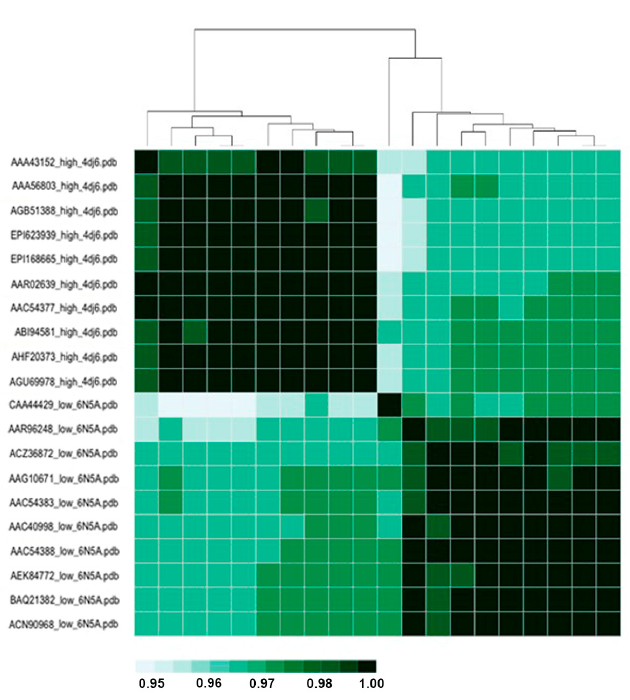
Figure 5. RMSIP heatmap for HPAI and LPAI RBDs. Uniprot AC for each sequence, followed by pathogenicity and PDB of the template are reported on the Y axis, while a distance tree is reported on the X axis.